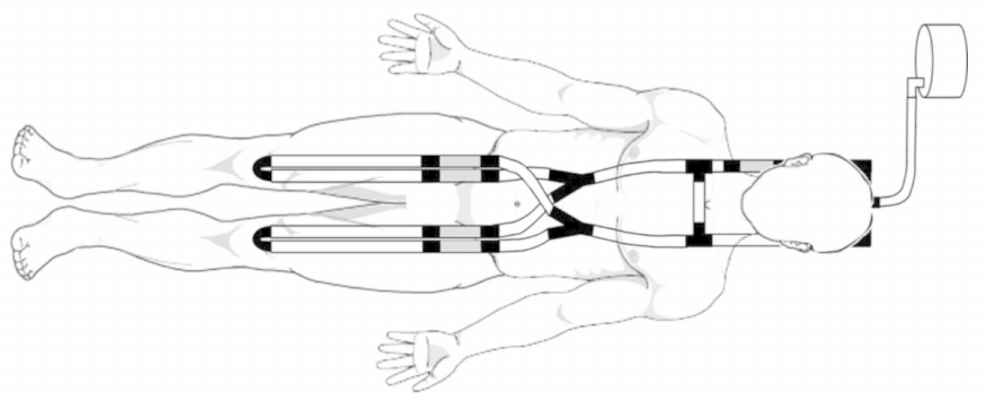
Figure 8. Endo circuit adult cannulation simulator [18].